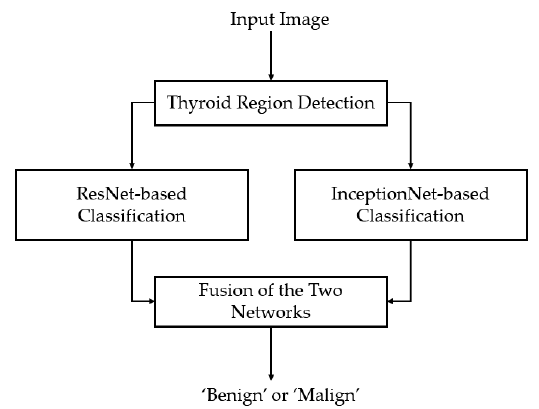
Figure 8. Flow-chart of the deep learning-based system constructed by combining classification results of multiple CNN networks. Table 2. ResNet50-based CNN architecture used in our experiments.